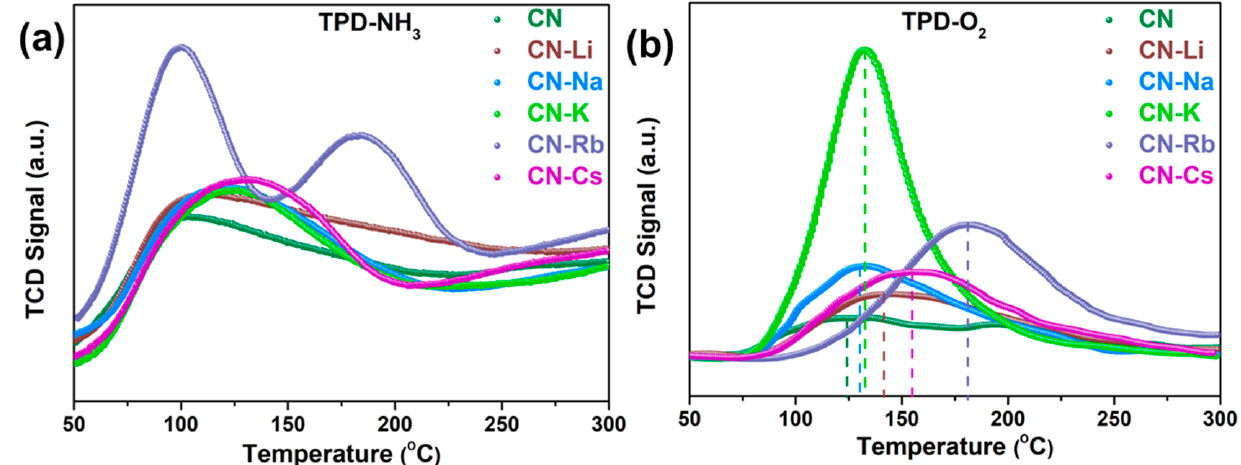
Figure 6. ( a ) TPD-NH 3 and ( b ) TPD-O 2 on the obtained PCN. Various reaction settings were used to examine the CN-M sample’s reaction pathway